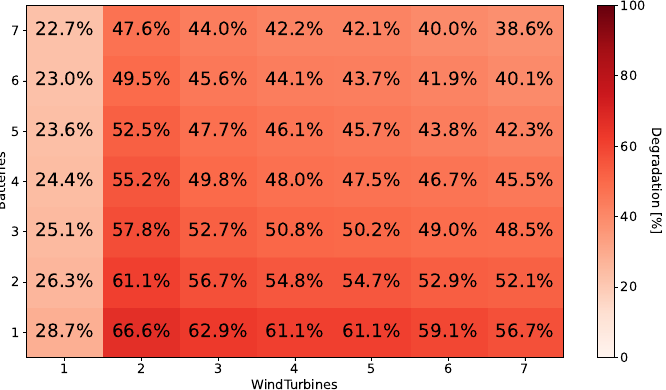
Figure 26. Degradation of the batteries over 20 years of usage with strategy 3.